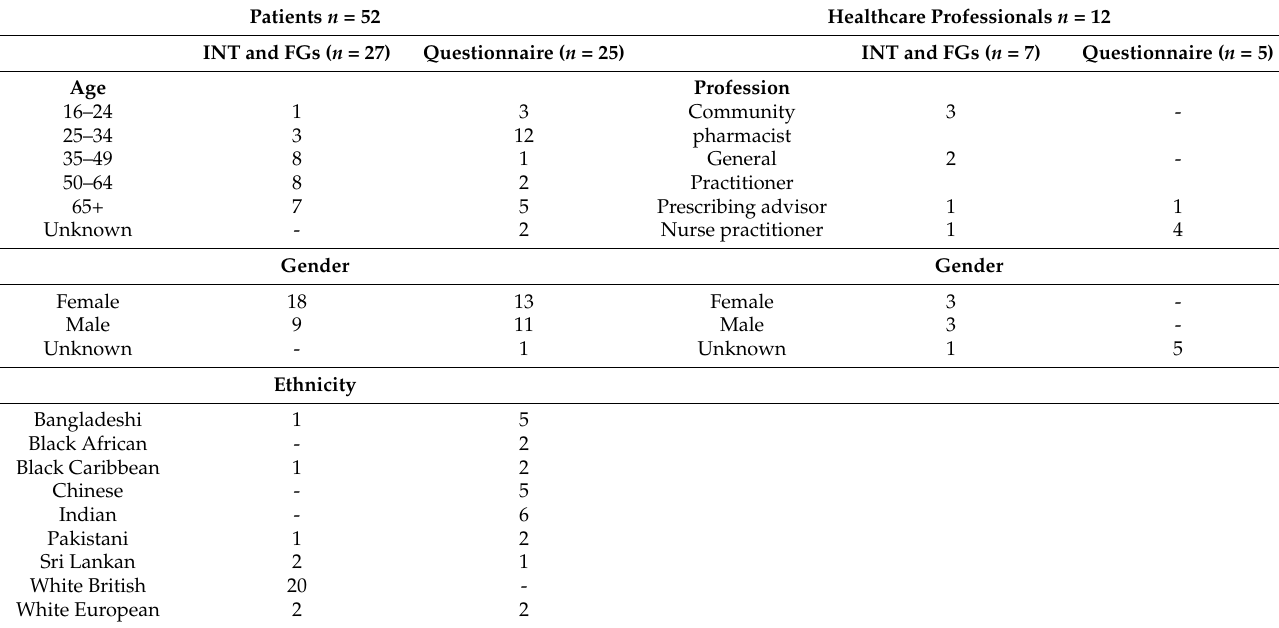
INT—Interviews. FGs—Focus